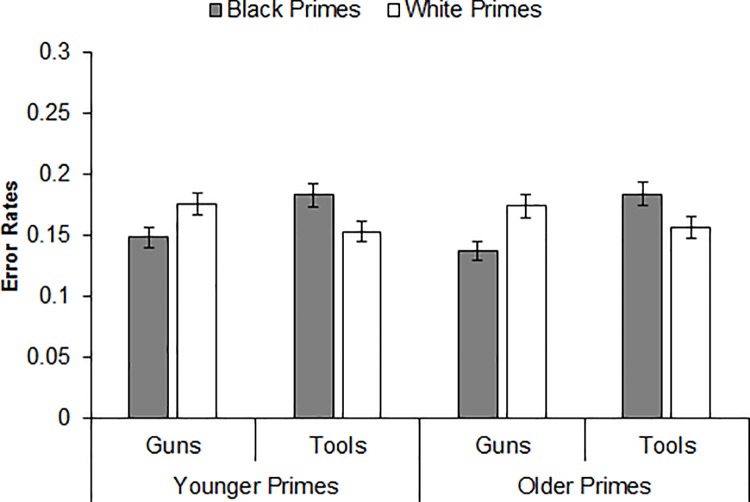
Mean error rates for gun and tool identifications by prime race and prime age (Experiment 1).